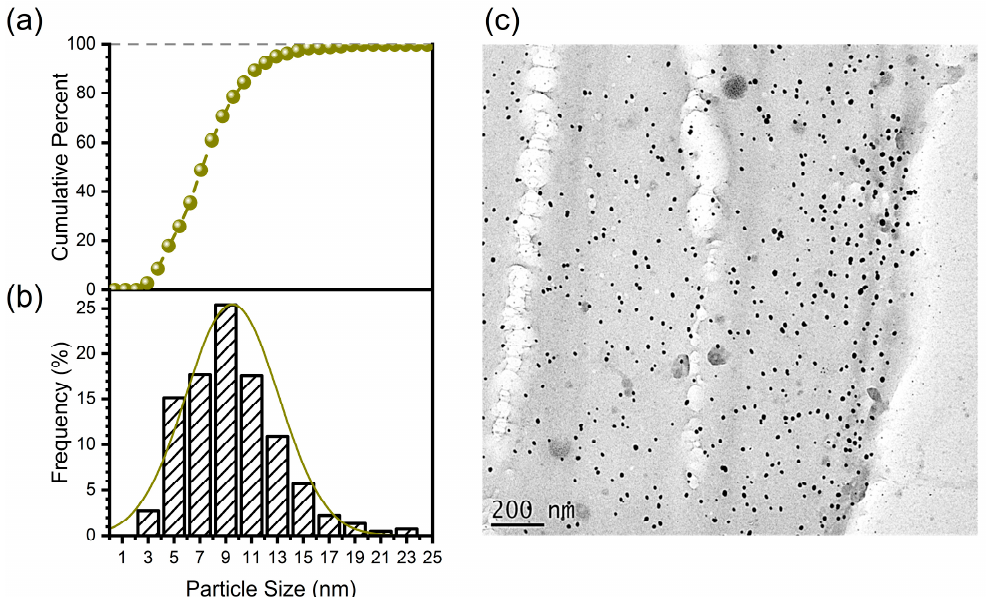
Figure 2. ( a , b ) Histogram and cumulative percentage of Ag NP size distribution (9.7 ± 3.2 nm) in the Ag NP–cotton catalyst as determined by ( c ) TEM image of the Ag NP–cotton catalyst fiber cross-section, confirming the internal formation and uniform distribution of Ag NPs within the entirety of the fiber.